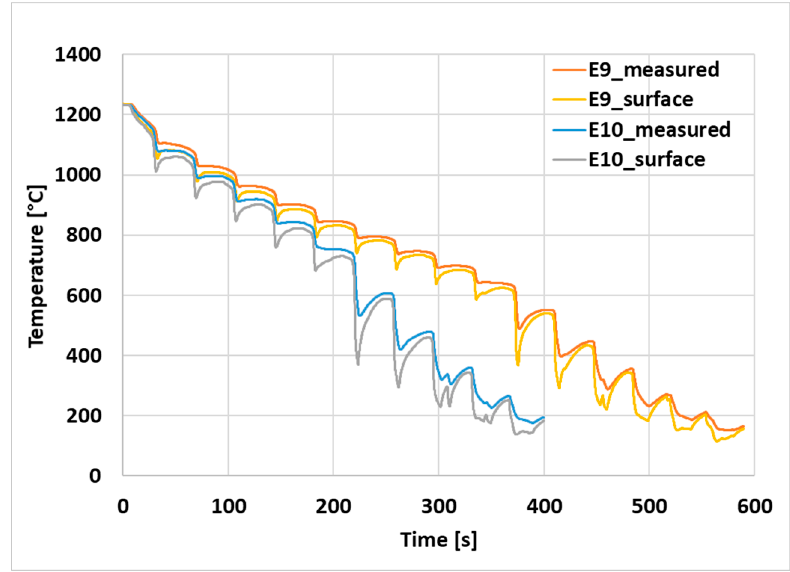
Figure 4. Temperatures measured at a depth of 2 mm and computed surface temperatures, data for experiments E9 and E10 at position of nozzle axis.